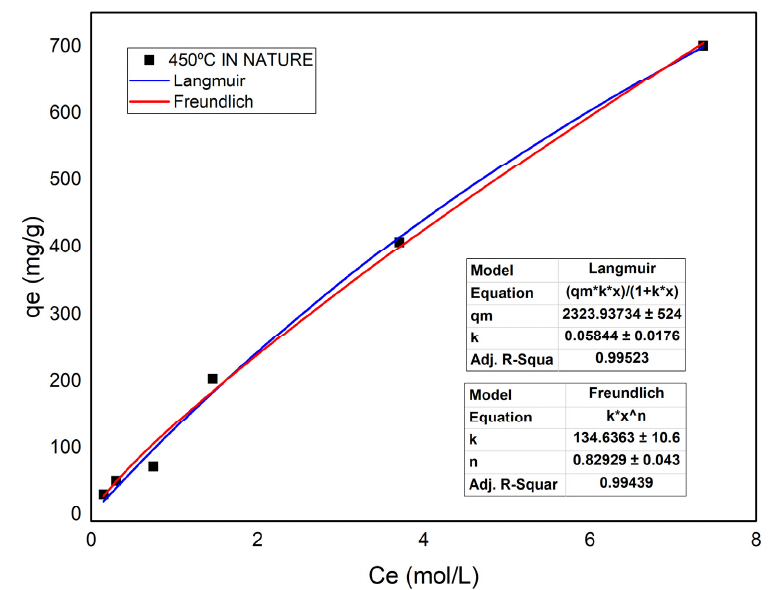
Figure 15. Langmuir and Freundlich isotherm model for adsorption experiment of in natura biochar obtained at 450 °C.